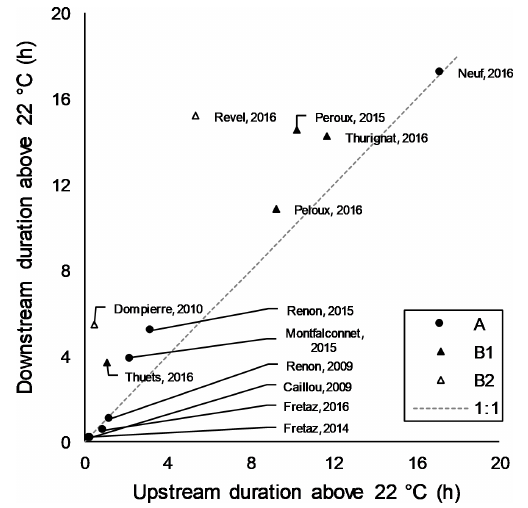
Figure 8. Mean of the daily maximum duration with a stream tem- perature above 22 ◦ C, upstream and downstream of each site mon- itored in the study. A (circles), B1 (closed triangles), and B2 (open triangles) are the groups of sites resulting from the hierarchical clus- ter analysis.